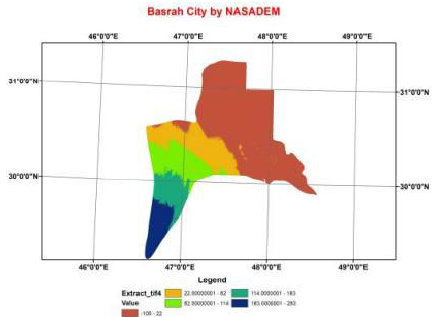
Figure 6. Map showing the NASA DEM m of the Basrah